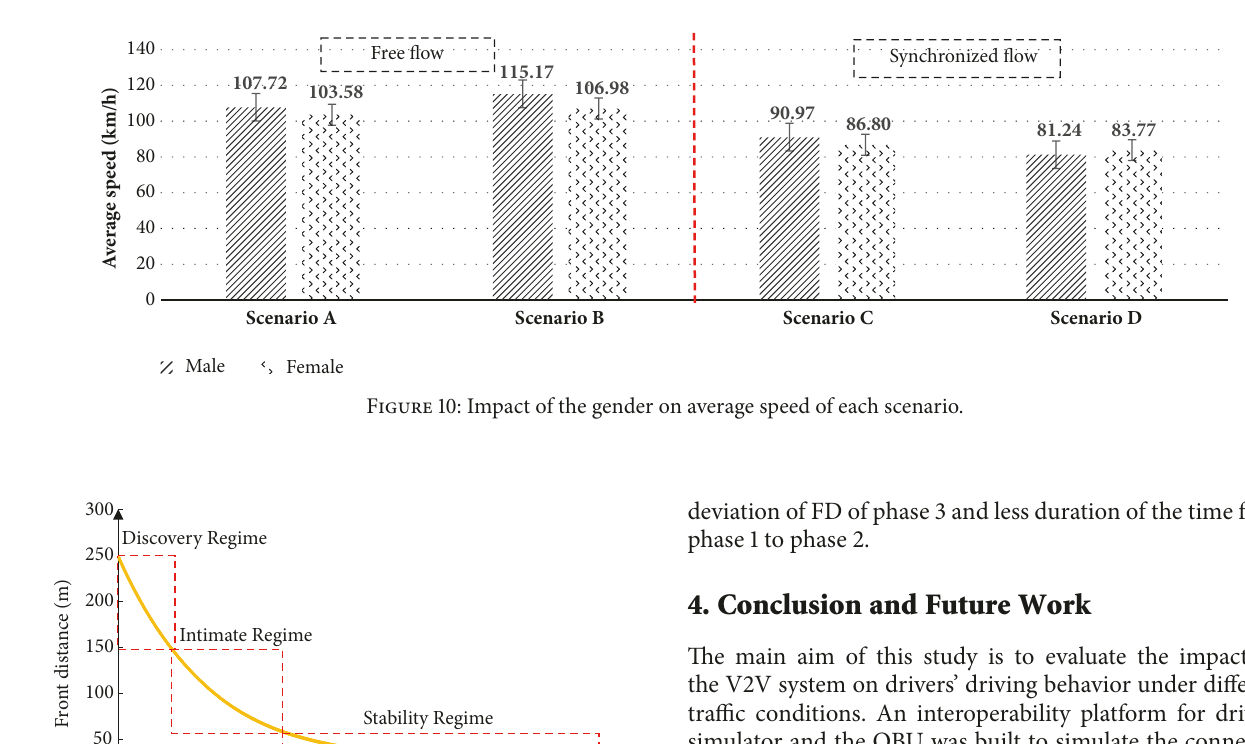
Figure 9: Impact of the OBU and traffic condition on acceleration profile of driver 26.